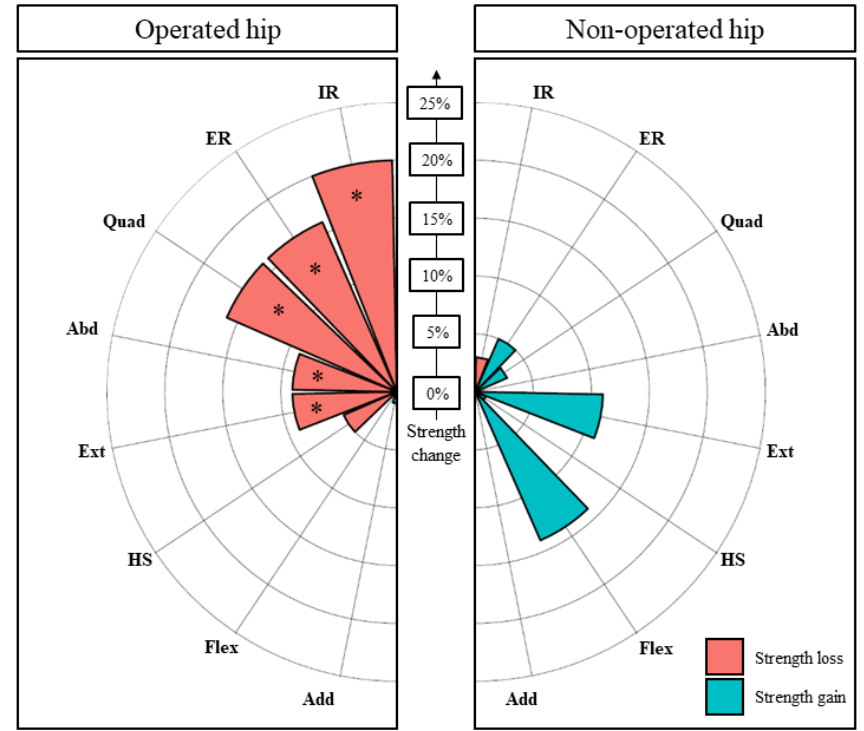
Figure 5. Pre- to postoperative changes (SHD) in muscle strength (%) on the operated and non- operated hips. * indicates a statistically significant variation. Internal rotators (IR), external rotators (ER), quadriceps (Quad), abductors (Abd), extensor (Ext), hamstrings (HS), flexors (Fl), adductors (Add).